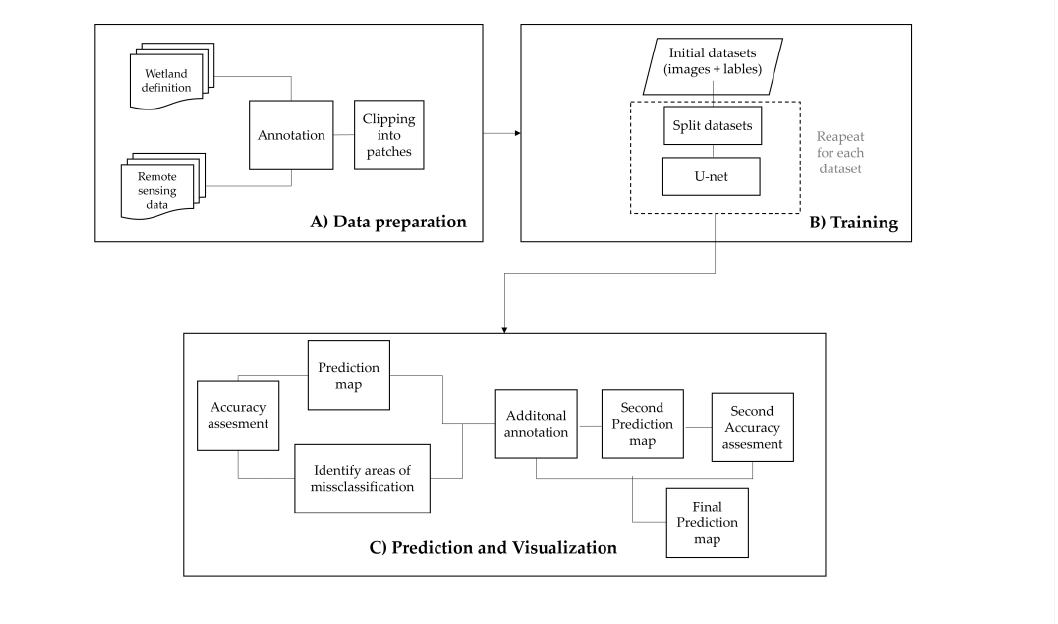
Figure 2. Workflow of the process of predicting open wetlands from Sentinel-2 imagery using TensorFlow and U-Net.